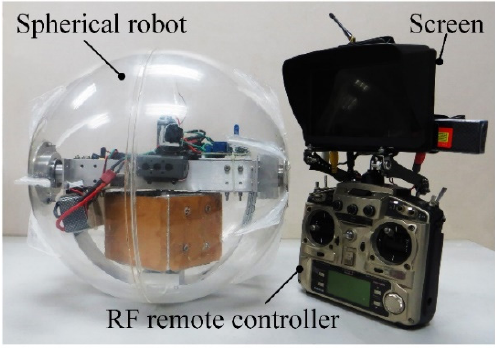
Figure 9. Amphibious spherical robot prototype.